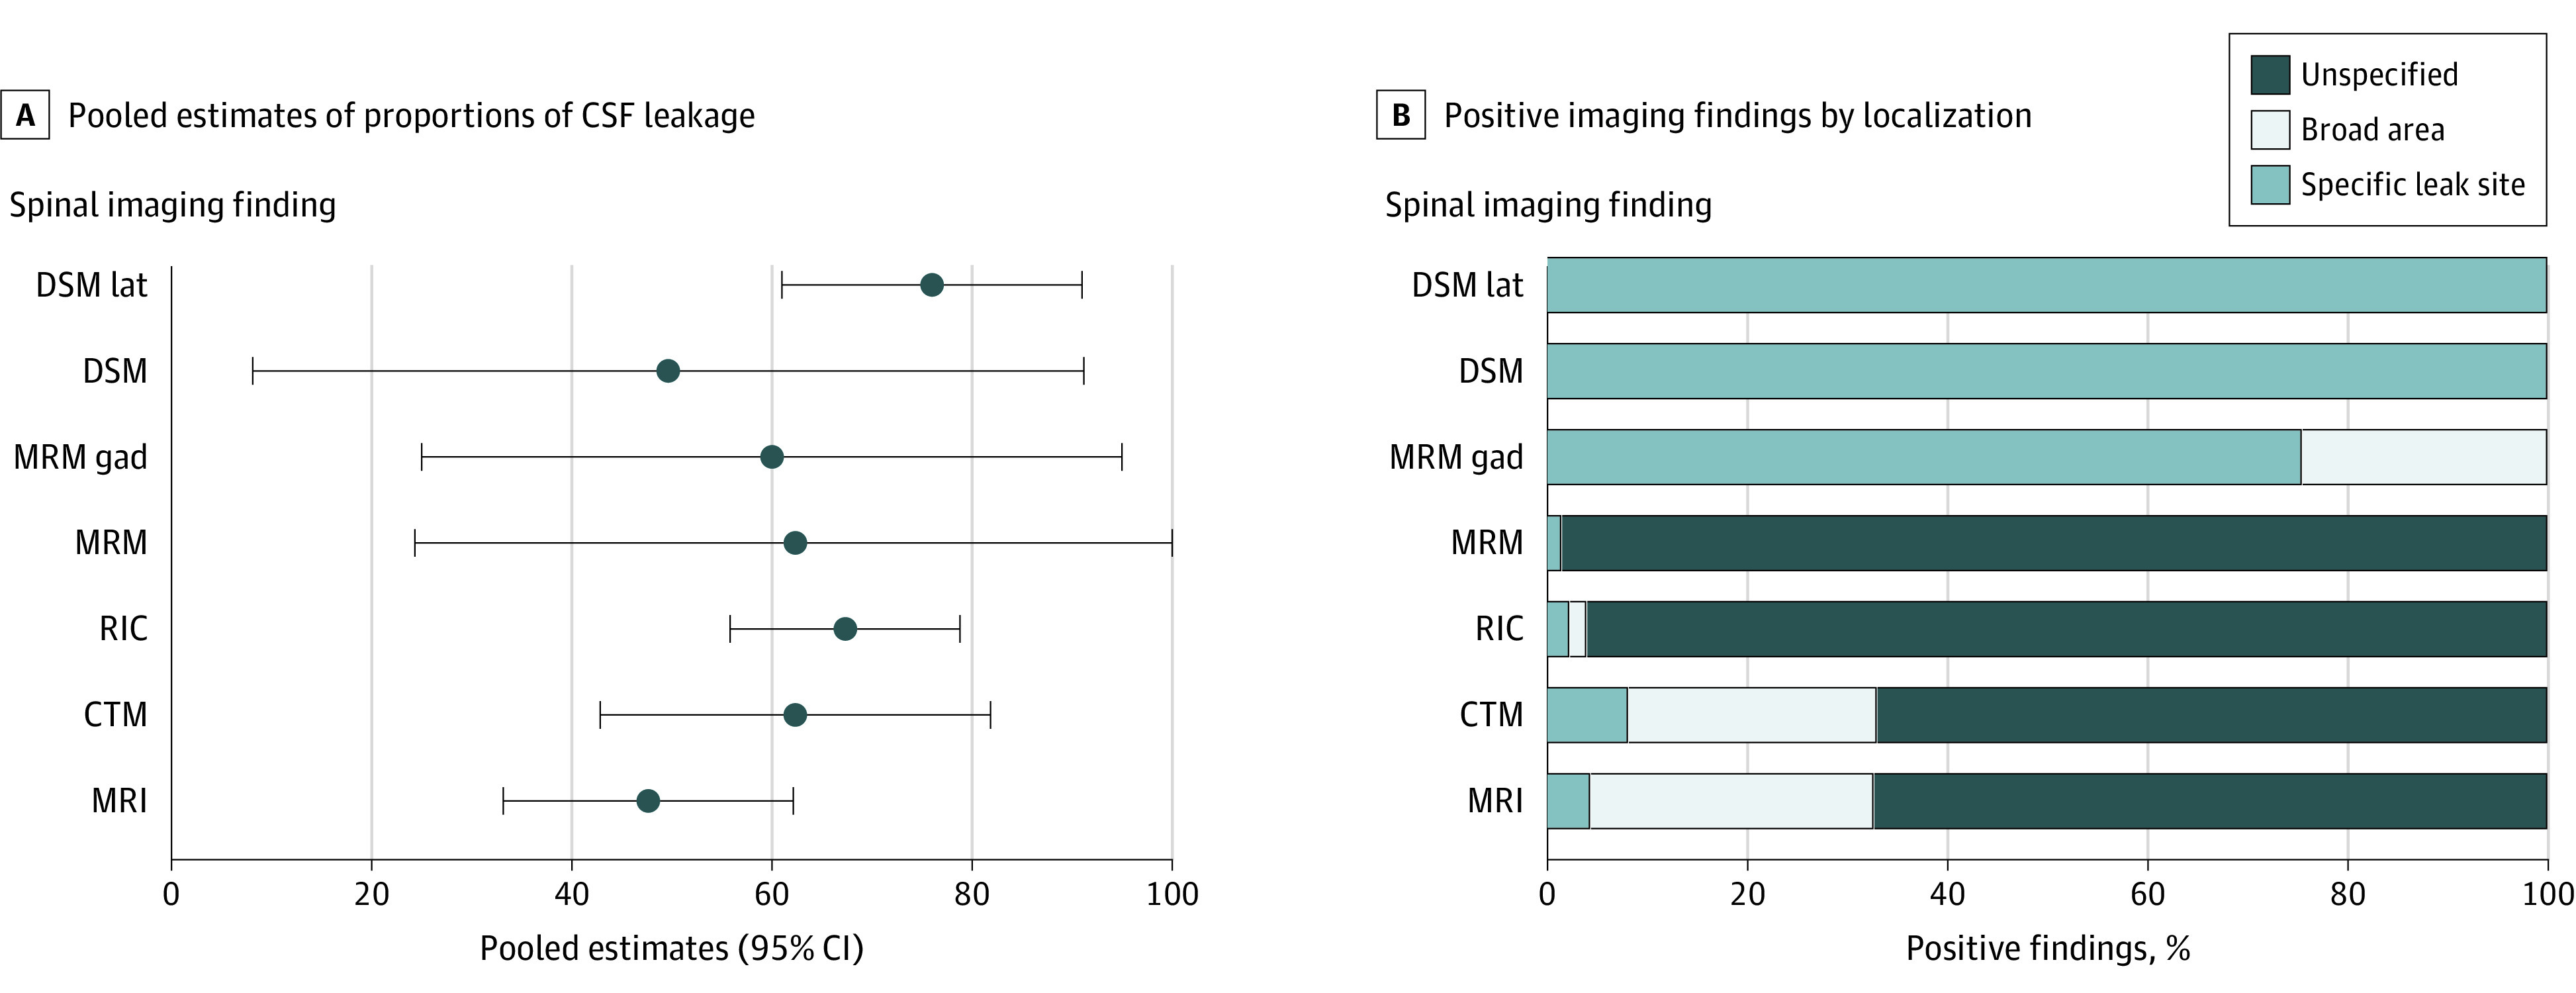
Spinal Imaging FindingsA, Pooled estimates of proportions (95% CI) of cerebrospinal fluid (CSF) leakage found in spinal imaging investigations. B, Positive imaging findings stratified by type of CSF leak localization: specific leak site, broad area, and unspecified. CTM indicates computed tomography myelography; DSM, digital subtraction myelography; DSM lat, digital subtraction myelography in lateral decubitus position; MRI, magnetic resonance imaging; MRM, magnetic resonance myelography; MRM gad, magnetic resonance myelography with intrathecal gadolinium; RIC, radionuclide cisternography.